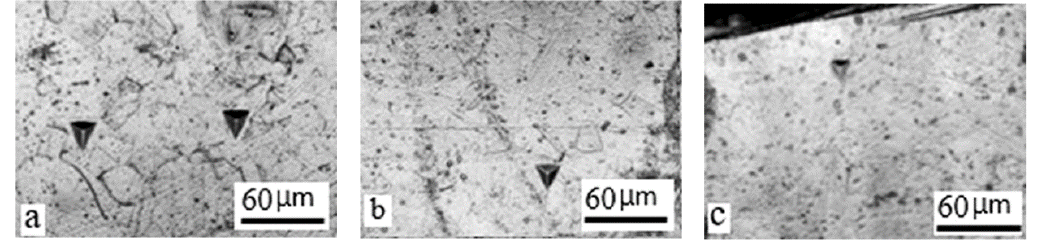
Figure 2. Images of sample microstructure and of imprints, made at different distances from the friction surface. Conditions: dry friction "metal/metal", AISI 316L steel/ St3sm = 1 hour, the arrow indicates the direction to the surface. steel; friction duration t fr